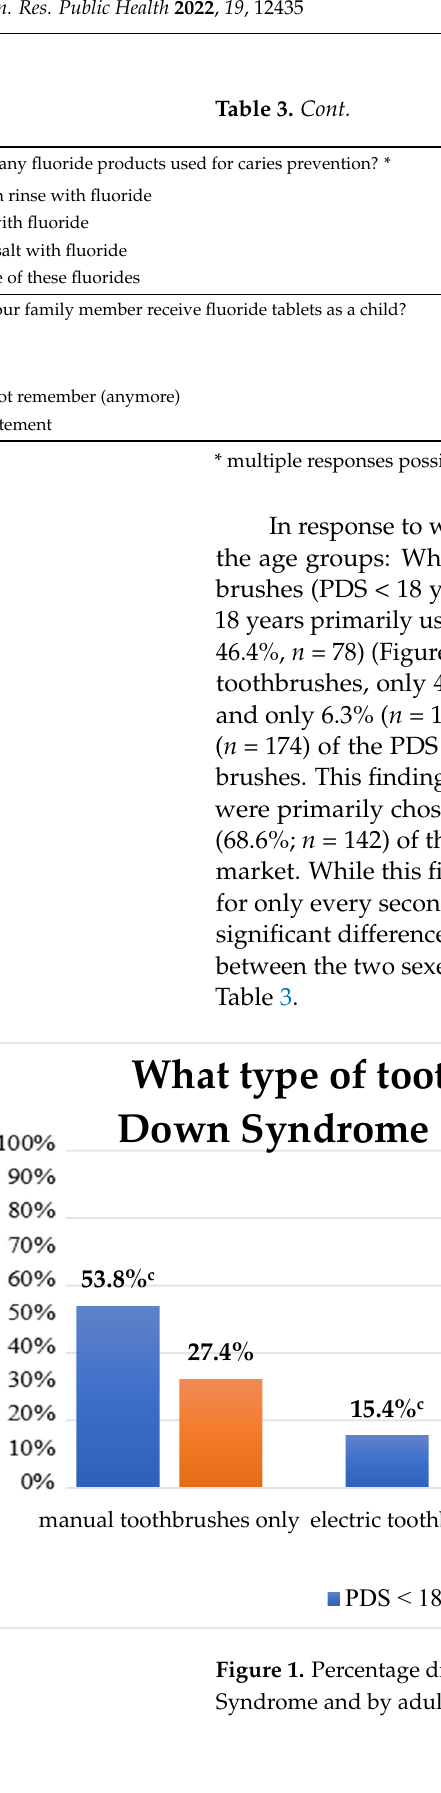
Figure 2. Percentage distribution of toothpaste preferences by children and adolescents with Down Syndrome and by adults with Down Syndrome ( d — p = 0.101). Use of fluoride in household products: In Germany, various products containing flu- oride are available for domestic use that can help prevent caries. The questionnaire asked about three scenarios in this context (Table 3). For the entire group, two-thirds (65.2%; n = 135) of the responding parents/caregivers of persons with Down Syndrome affirmed that they used fluoridated table salt in the preparation of meals at home. The use of fluoride mouth rinses (20.3%; n = 42) or fluoride gels (12.6%; n = 26) was less common. Further details in this regard, for instance, for the two age groups, can be found in Table 3. The use of dental health services and professional supportive oral hygiene interven- tions: In the majority of cases (62.4%; n = 127), the PDS had reportedly been older than